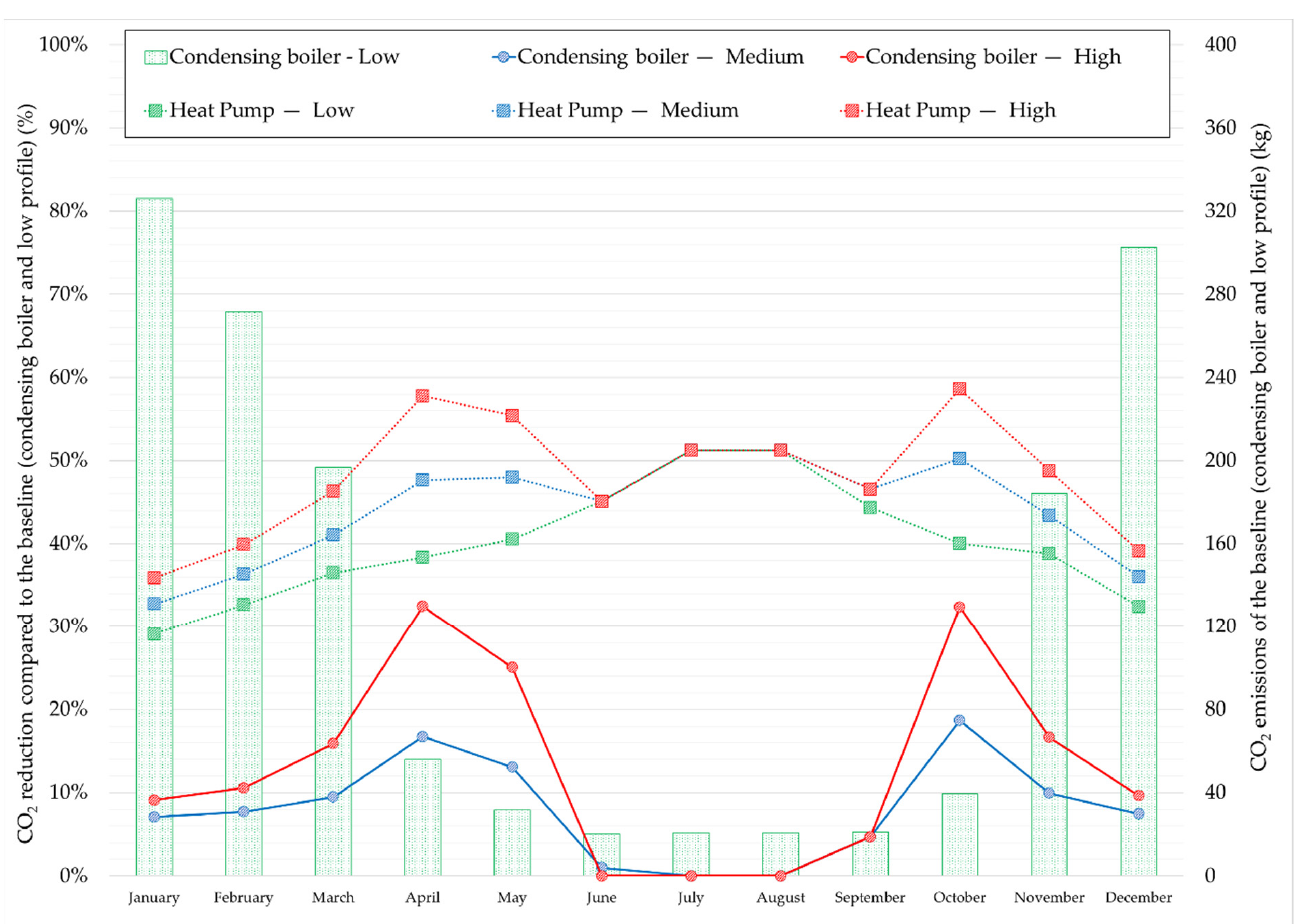
Figure 15. Environmental effects due to the different analysed profiles and heating and domestic hot water production system configurations.